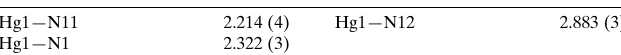
The complete molecule of the complex,